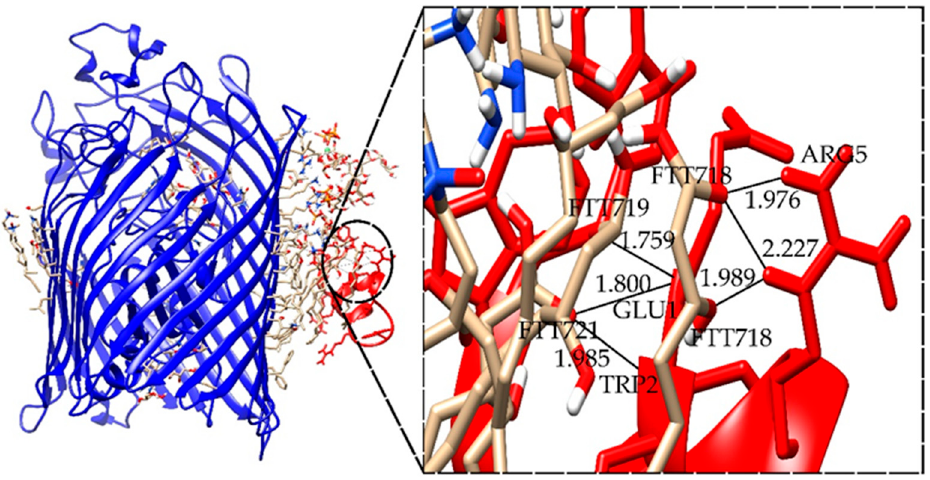
Figure 6. Structure of LPS–FhuA+M6_B_1 complex. The images of the remaining selected complexes can be found in the supplementary